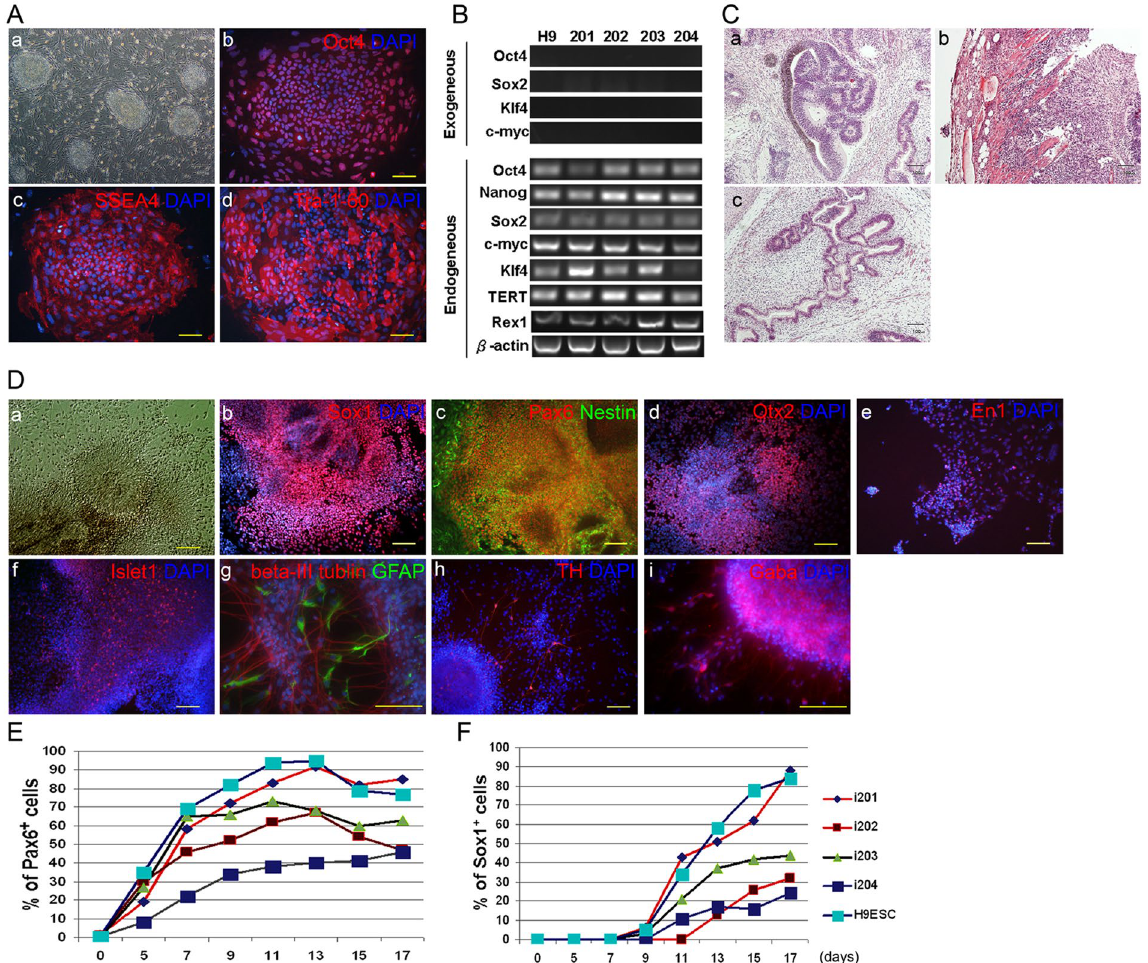
Figure 1. Derivation, characterization, and neural differentiation of human iPSCs. ( A ) Phase-contrast (a) and immunocytochemistry of colonies derived from human iPSCs (clone 201), which express ESC markers, including Oct4 (b), SSEA4 (c), and TRA-1-60 (d). Nuclei were counterstained with DAPI. ( B ) RT-PCR analysis of the expression of retroviral transgenic (exogenous) and endogenous Oct4, Sox2, Klf4, and c-Myc in 4 putative iPSC clones (clones 201–204) and the human ESC line H9. Note that the silencing of all 4 transgenes and the reactivation of their endogenous counterparts was observed in all of the iPSC clones. ( C ) H&E staining of teratomas from iPSCs (clone 201) in NOD-SCID mice containing ectodermal (a), mesodermal (b), and endodermal (c) lineages. ( D ) Morphology and immunoreactivity of iPSCs (clone 201) and the derivative iPSC- NPCs in a time sequence: phase contrast image of neural progenitors in a rosette-like structure (a); expression of early neural progenitor markers Sox1 (b) and Pax6 (c); region-specific forebrain marker Otx2 (d), midbrain marker En1 (e), and hindbrain marker Islet1 (f); after one month of differentiation, partial expression of the neuronal marker ß-III tubulin and the astrocytic marker GFAP (g), neuronal TH (h), and neuronal GABA (i). ( E , F ) FACS analysis of the proportion of Pax6- and Sox1-positive neural progenitors at various stages of differentiation (x-axis: days in vitro ) from different iPSC clones (i201–204) and H9 ESCs. The data are averaged from 3 replicates for each clone. Scale bar ( A , C , D ) = 100 µ